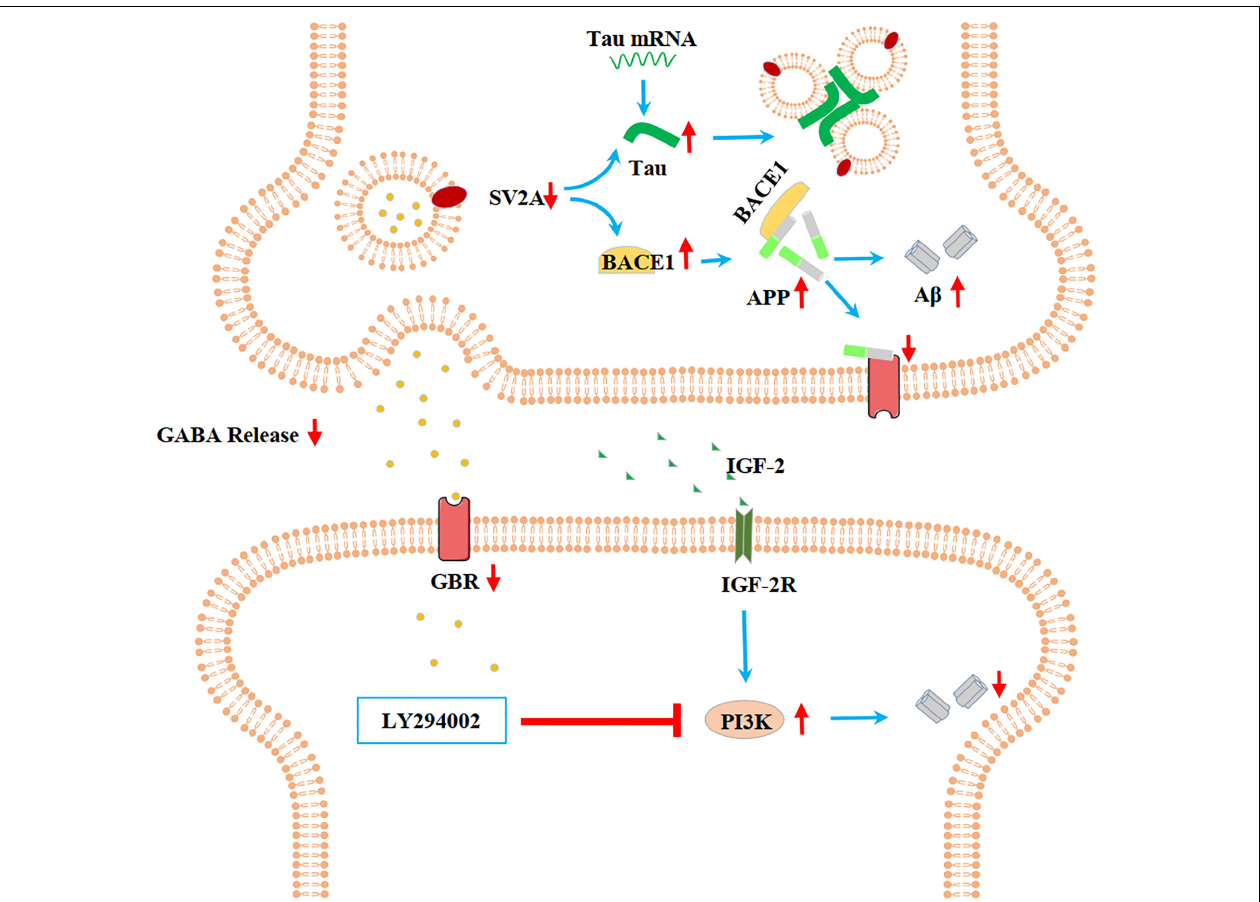
FIGURE 6 | Schematic diagram showing that the deficiency of SV2A up-regulates Tau expression to reduce the inhibition of the impairment of synaptic vesicle information transmission, up-regulates BACE1 expression, and inhibits GBR-stabilizing APP on the cell surface, thus promoting the proteolysis of APP to A β . SV2A also regulates the PI3K pathway. SV2A regulates AD-related proteins via the above three